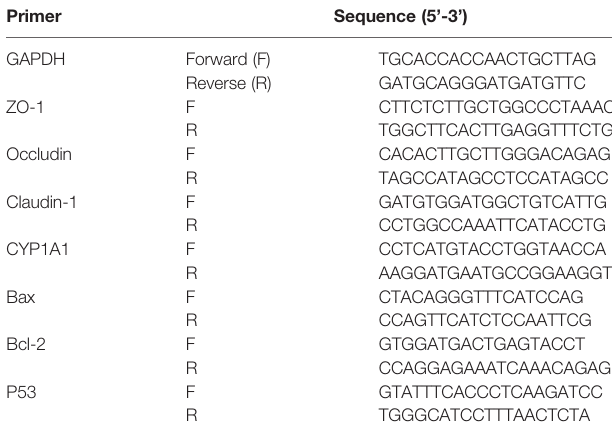
TABLE 2 | Primer sequences used for